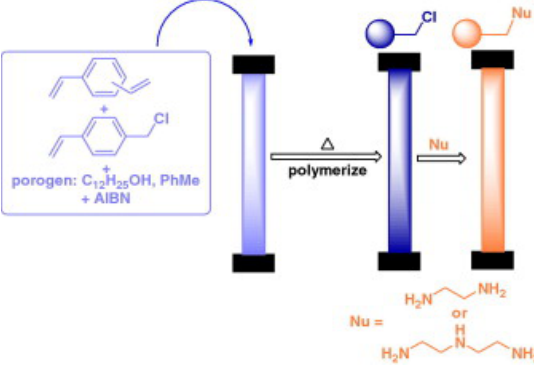
Figure 15. Preparation and modification of monolithic columns [147]. Reprinted with permission from Elsevier